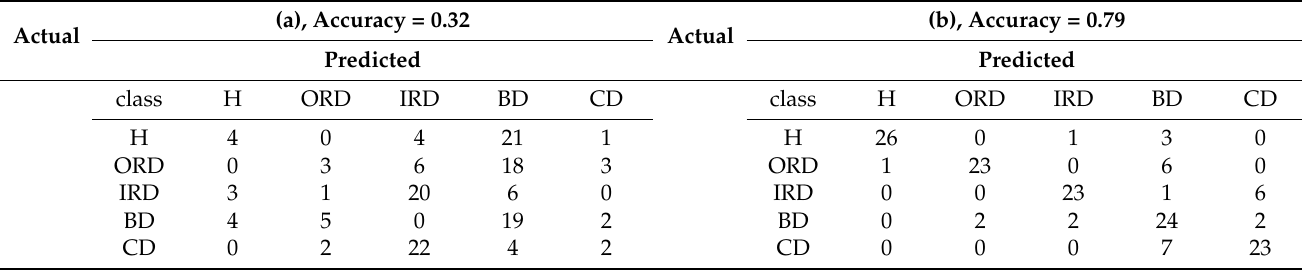
Table 2. Confusion matrices for the case of raw data: (a) using conventional features; (b) using updated features. Actual